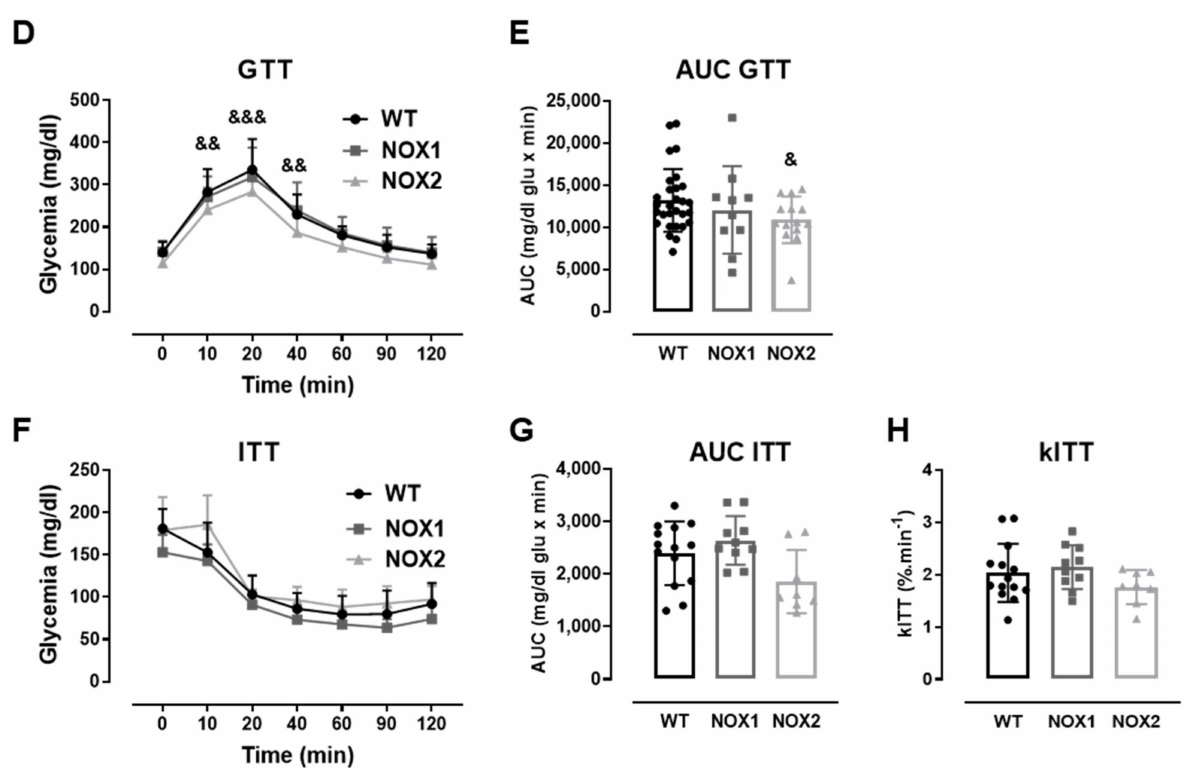
Figure 3. The role of NOX2 in islet function in vivo and ex vivo. ( A , B ) The insulin secretion of islets from WT and NOX2 KO (NOX2) islets exposed to a proinflammatory cytokine mix (10-U/mL IL-1 β + 100-U/mL TNF + 14-U/mL IFN- γ ). The islets were cultured in 10-mM glucose for 24 ( A ) or 48 h ( B ) and then incubated with 5.6 or 16.7 mM of glucose for 1 h. The results are expressed as the mean ± SD of 5 independent experiments. ** p < 0.01 versus the respective control of the same genotypes using a Student’s t -test. ( C ) Intracellular insulin contents of the WT and NOX2 islets in ( A , B ). After the insulin secretion assay, the islets were pooled for each condition (24 h or 48 h) and disrupted in a solution of acid–ethanol for an analysis of the intracellular contents of insulin. The results are expressed as the mean ± SD of 5 independent experiments. ( D , E ) The Glucose Tolerance Test (GTT) of WT, NOX1 KO (NOX1) and NOX2 KO (NOX2) mice. The animals were fasted for 10–12 h. The glycemia was then measured from the tail vein using a glucometer at time zero (0) and after the i.p. administration of glucose (1-g glucose/kg) at 10, 20, 40, 60, 90 and 120 min. ( D ) GTT curve (mg/dl). ( E ) Area under the curve (AUC) of ( D ). The results are expressed as the mean ± SD of 29, 10 and 14 animals for WT, NOX1 KO and NOX2 KO, respectively. ( F – H ) The Insulin Tolerance Test (ITT) of WT, NOX1 KO (NOX1) and NOX2 KO (NOX2) mice. The animals were fasted for 4 h. The glycemia was then measured from the tail vein at time zero (0) and after the i.p. administration of insulin (0.75-U insulin/kg) at 10, 20, 40, 60, 90 and 120 min. ( F ) ITT curve (mg/dl). ( G ) AUC of ( F ). ( H ) K ITT . The results are expressed as the mean ± SD of 14, 10 and 8 animals for WT, NOX1 KO and NOX2 KO, respectively. & p < 0.05, && p < 0.01 and &&& p < 0.001 represent NOX2 versus WT using a two-way ANOVA + Dunnett’s ( D ) or a Student’s t -test ( E